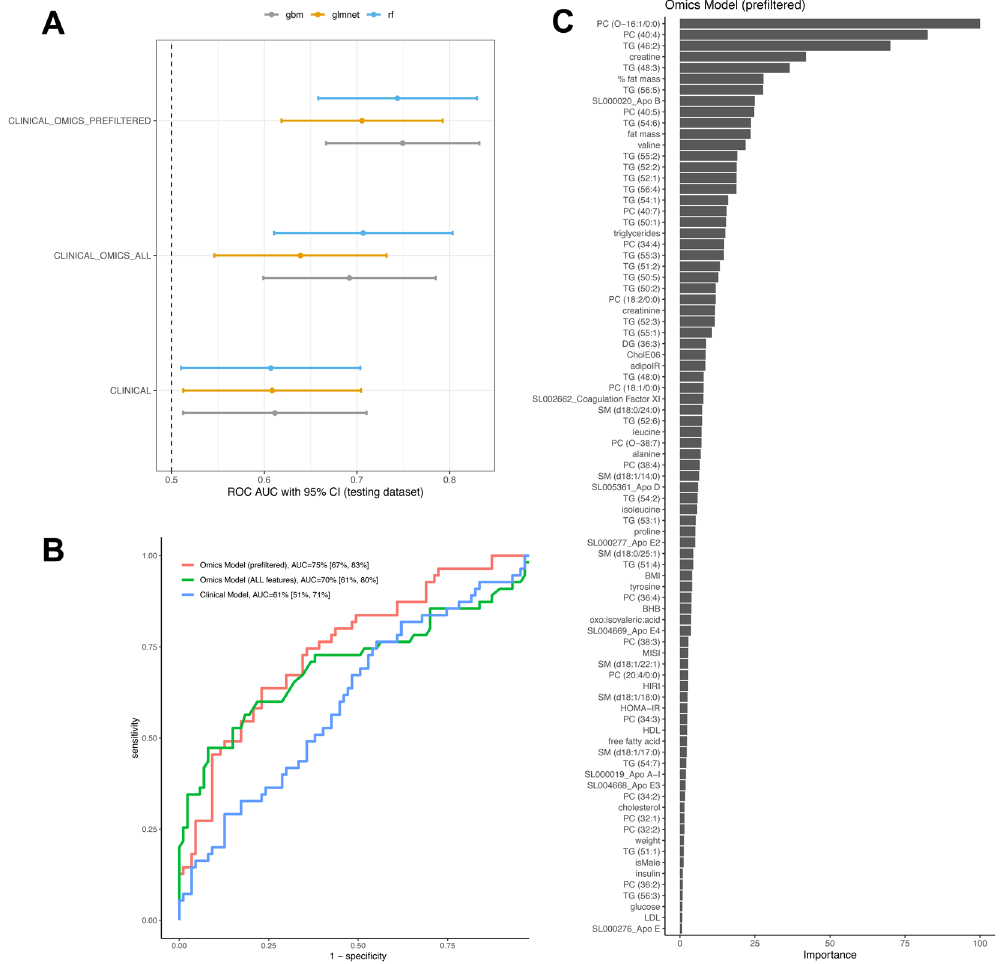
Figure 7. Predictive models based on baseline clinical and plasma omics. ( A ) Receiving Operating Curves (ROC) Area Under the Curve (AUC) for each model (3 set of features × 3 type of models). Performance is evaluated on the testing set (not used for constructing the models). AUCs and their 95% Confidence Intervals are shown. The line at AUC 50% indicates the performance from a random predictor. Models based on clinical parameters uses as input 19 features, the full omics model includes 1246 features, while the prefiltered omics model is a subset and uses 93 features as input (see Methods for full details). ( B ) ROC curves (on testing data) for the best models from the 3 set of features. The clinical model is based on an elastic net (glmnet), the Omics model with all features is a random forest, while the Omics models with prefiltered features is a gradient boosting machine. ( C ) Feature importance plot for the features retained by the gradient boosting machine model (constructed using the prefiltered Omics features as